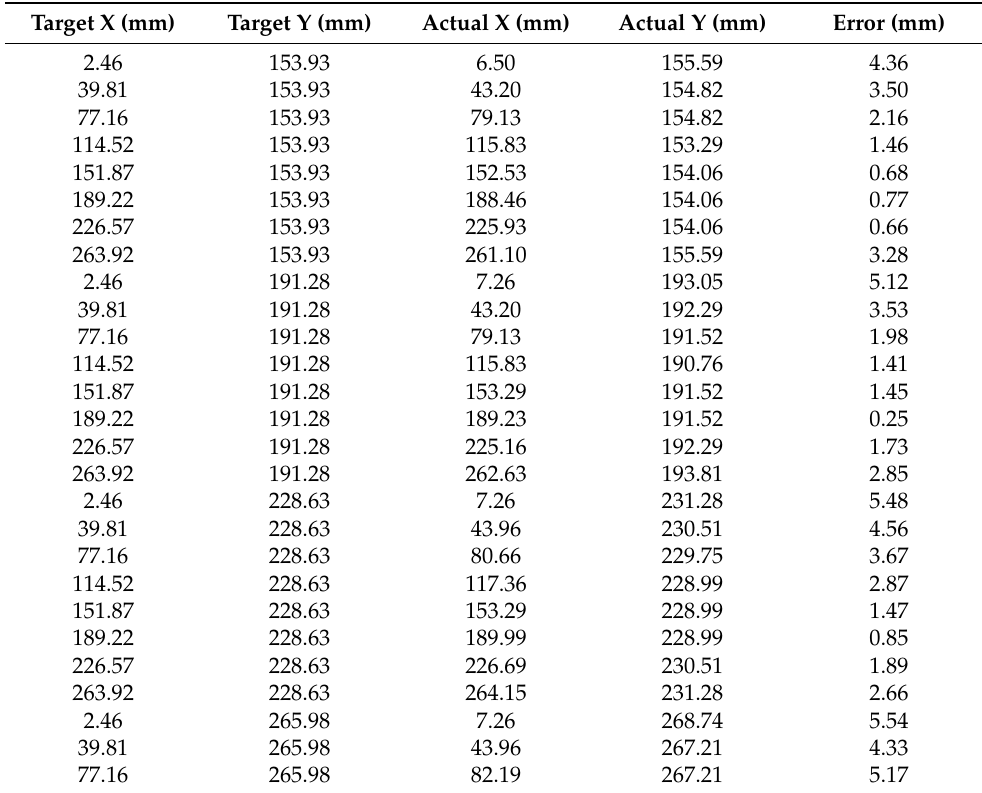
Table A4. Run 2 positional data (upper half of the